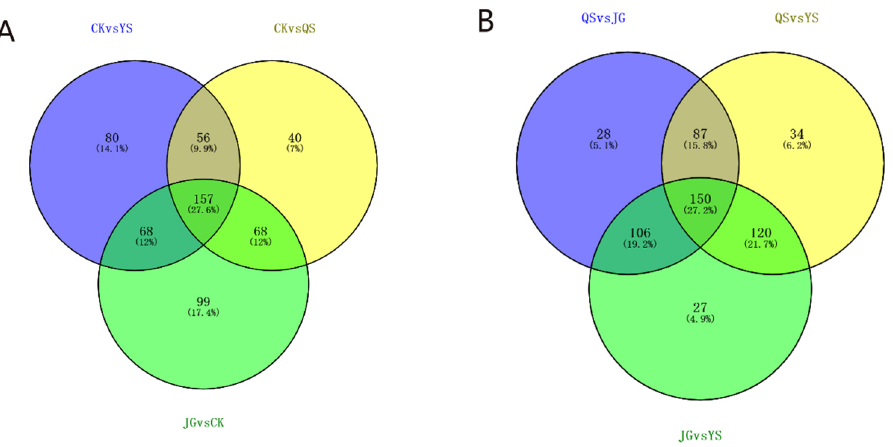
Figure 5. Venn diagrams of differential metabolites among different comparison groups. ( A ) CK vs. YS, CK vs. QS, and CK vs. JG; ( B ) QS vs. JG, QS vs. YS, and JG vs. YS.